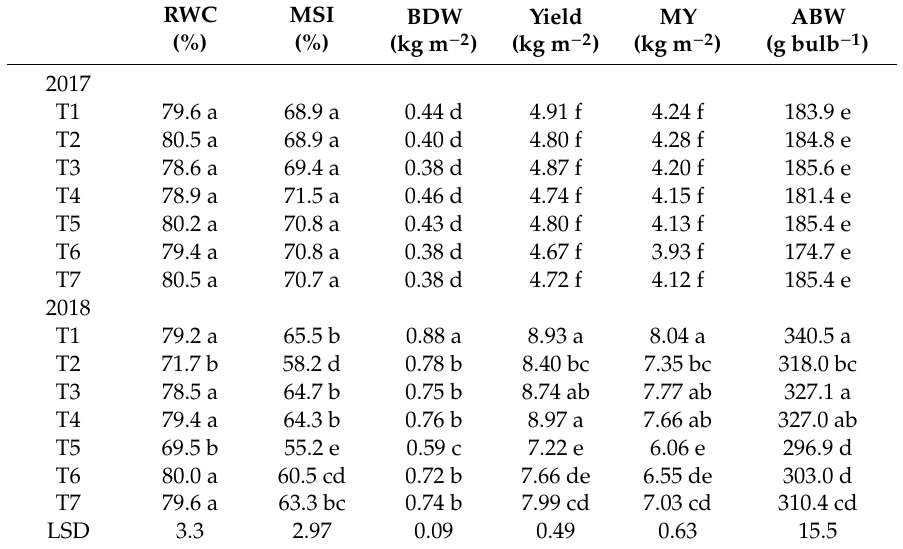
Table 3. Growing season–irrigation strategy interaction for the relative water content (RWC) and membrane stability index (MSI) at the end of the vegetative growth, bulb dry weight (BDW), total yield (Yield), marketable yield (MY), and average bulb weight